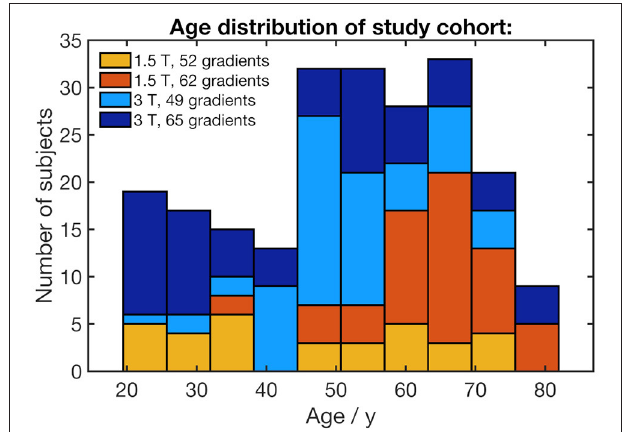
FIGURE 1 | Stacked histogram of the study cohort’s age distribution. The age bracket colorization represents the number of subjects who underwent four different scanner